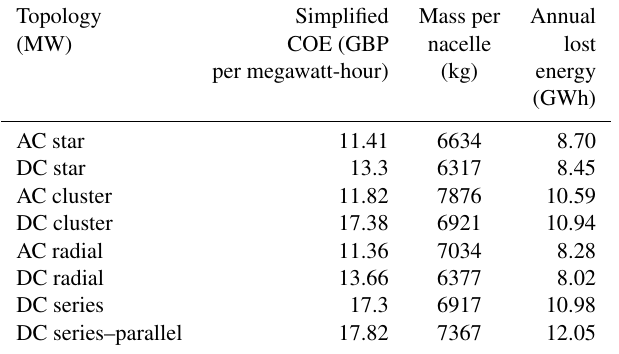
Table 3. Comparison of characteristics of each electrical topology.